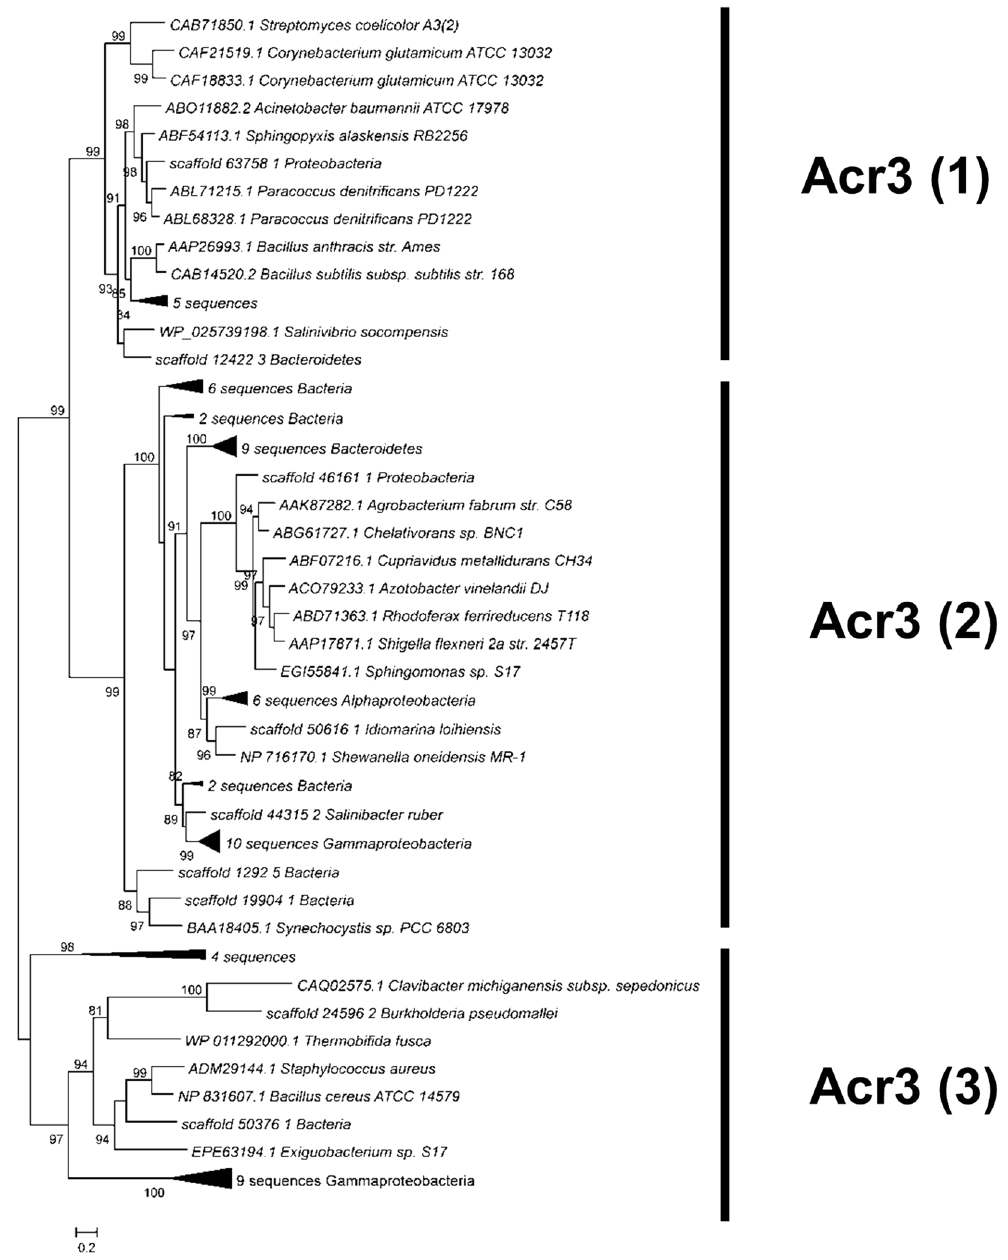
Figure 5. Maximum likelihood tree for Acr3 proteins, including 62 sequences from Socompa and 21 sequences from NCBI nr database. Metagenomic sequences with the same affiliation in the same branch are collapsed. The three groups of the Acr3 family are marked, and all of them include Socompa